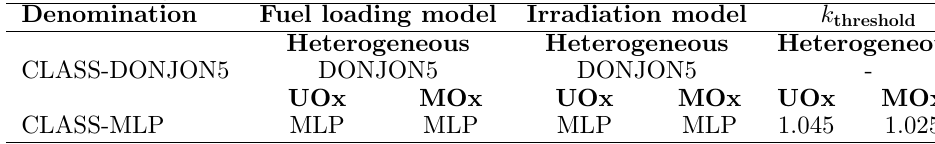
Table 11. Reactor modeling description and denomination.